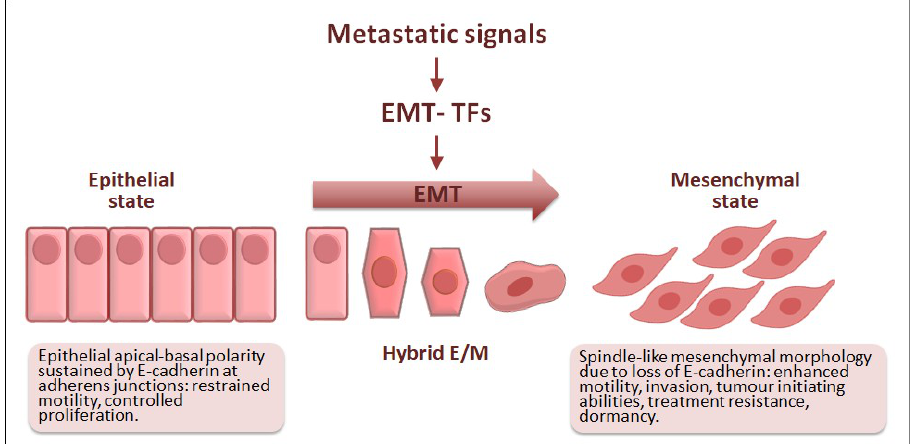
Figure 2. Epithelial-mesenchymal transition (EMT) in cancer progression. Different metastatic